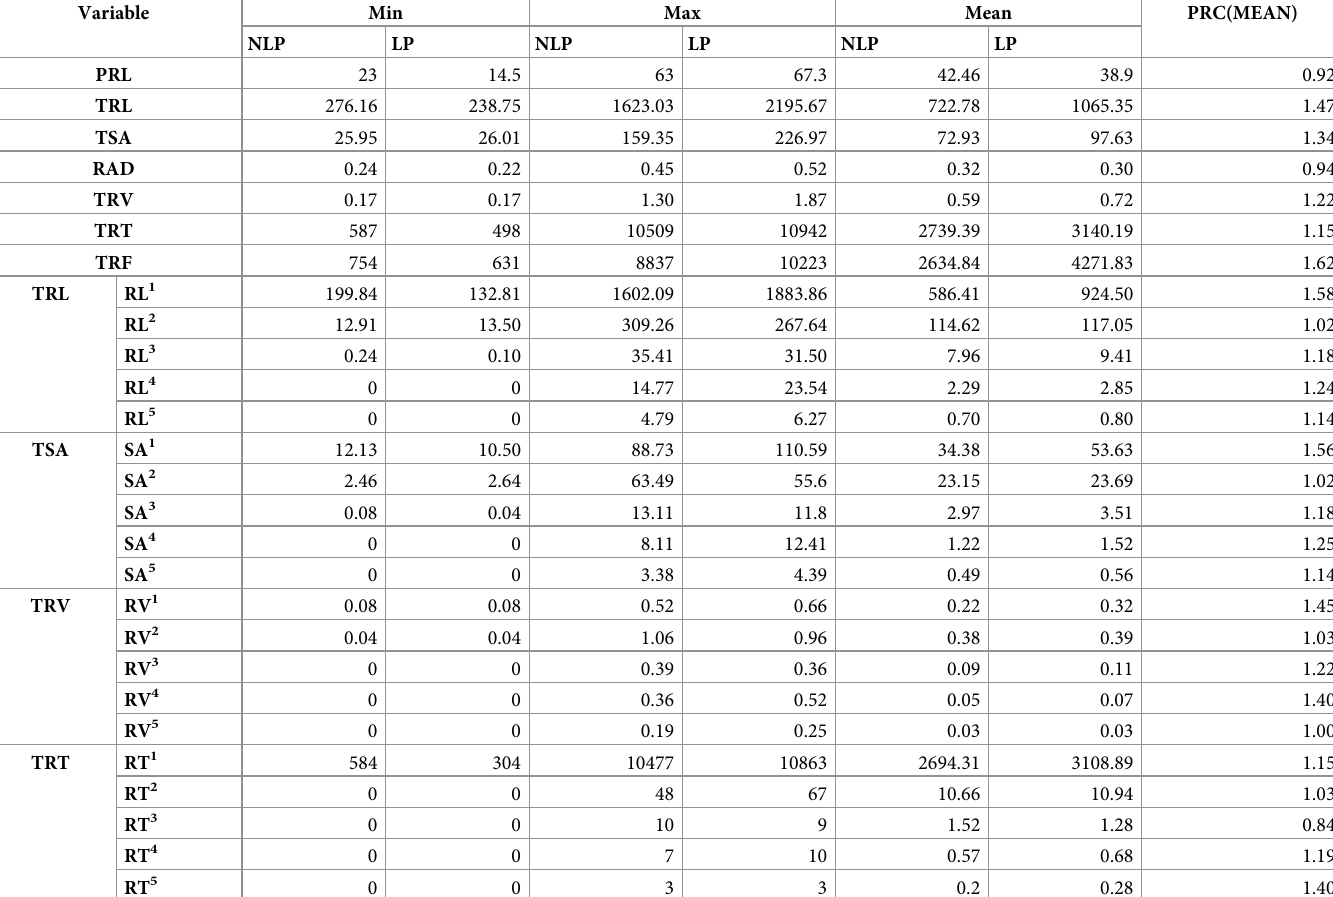
Table 2. Measures of variability and Phosphorus Response-Coefficient (PRC) for roots system architectural and their subclass traits under non-limiting and limit- ing phosphorus conditions.